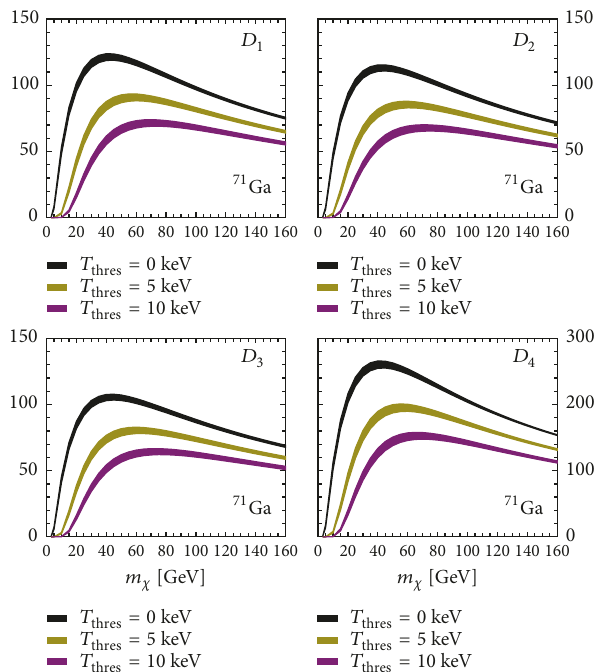
Figure 7: Nuclear structure coefficients 𝐷 푖 for 71 Ga plotted as a function of the WIMP mass. The graphs are plotted for three values of the detectorthreshold 0, 5, and 10 keV. The thicknessof the graphs represents annual modulation.